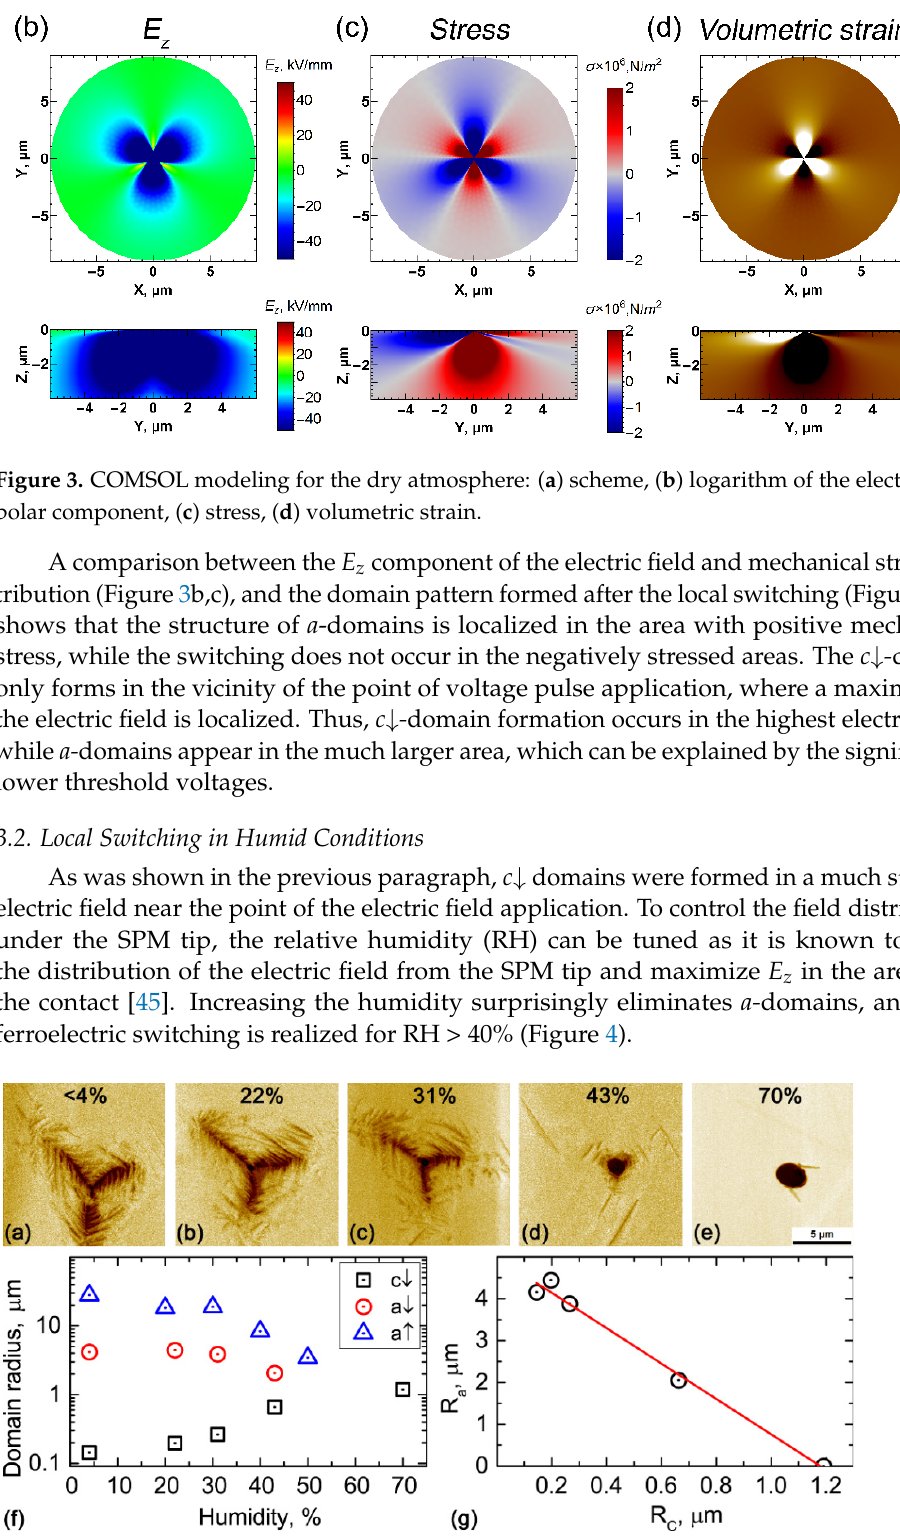
Figure 4. Local switching at different relative humidity: ( a ) < 4%, ( b ) 20%, ( c ) 30%, ( d ) 40%, and ( e ) 70%. ( f ) Dependence of domain size on relative humidity. ( g ) Dependence of the mean radius of a ↓ -domains on the radius of the central c -domain. Voltage 90 V, pulse duration 500 ms.